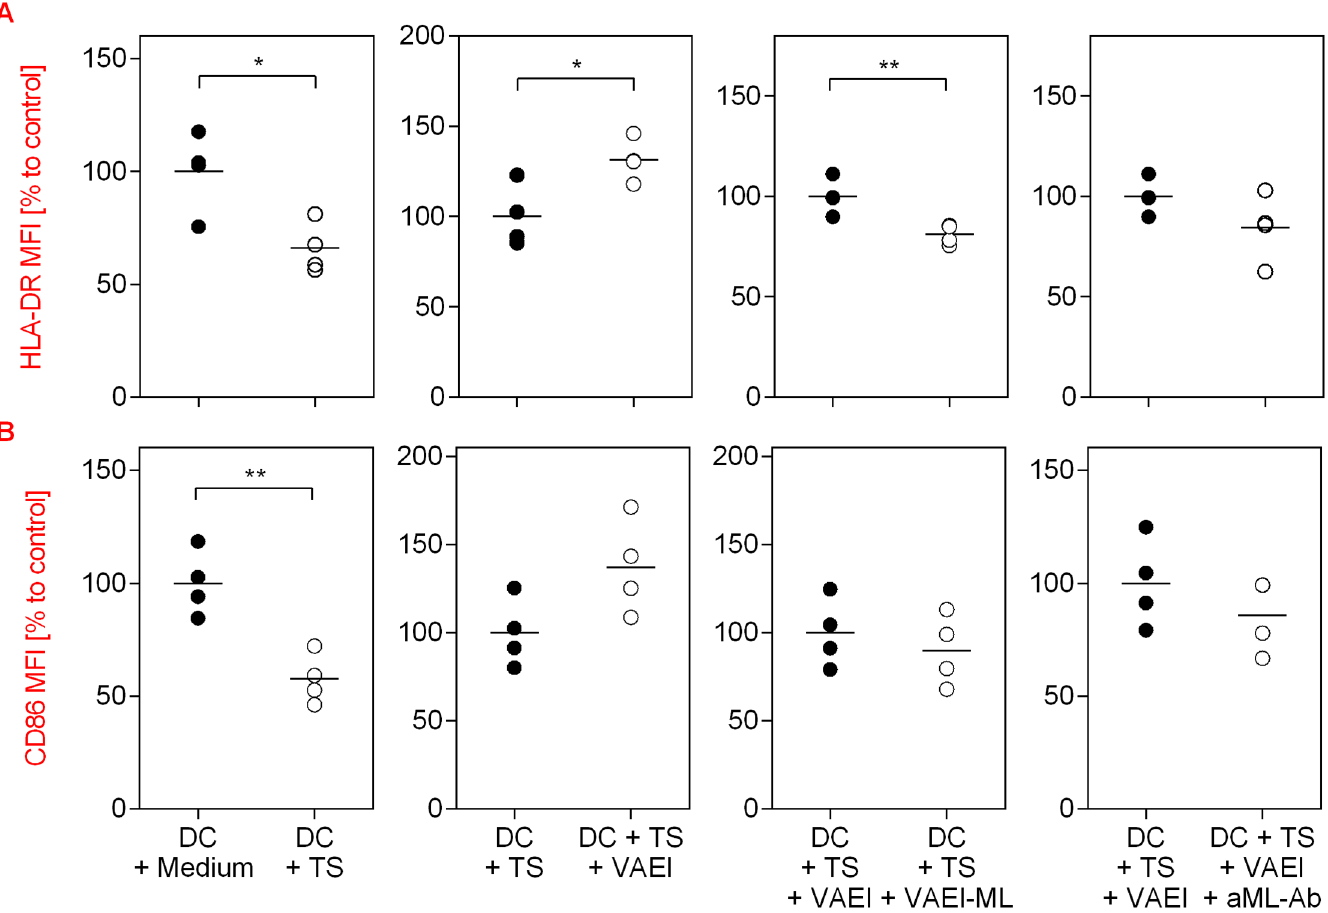
Fig 8. Fluorescence microscopy of the effects of VAEI on the restoration of CD86 and HLA-DR expression on DC after tumor-induced immunosuppression and the impact of mistletoe lectins. Unstimulated CD14 + -derived DC were treated with 10% RPMI 1640medium (DC + Medium), 10% tumor supernatantof an RCC line (DC + TS) or 10% tumor supernatant and VAEI (DC + TS + VAEI; Iscador ® Qu Spez; 0.5 μ g/ml), ML-depletedVAEI (DC + TS + VAEI-ML; Iscador ® ;0.66 μ g/ml), or VAEI and anti-ML antibody(DC + TS + VAEI + aML-Ab; 2.5 μ g/ml). After cultivationautomatedfluorescence microscopyand quantitative analysisof HLA-DR (A) and CD86 (B) expressionwas carried out. MFI = Mean fluorescence intensity. Data and mean of 4 individualexperiments are presented in relationto untreatedcells (DC = 100%). Asterisks indicatesignificantdifferencesbetweenthe groups ( * P < 0.05, ** P < 0.01, *** P <